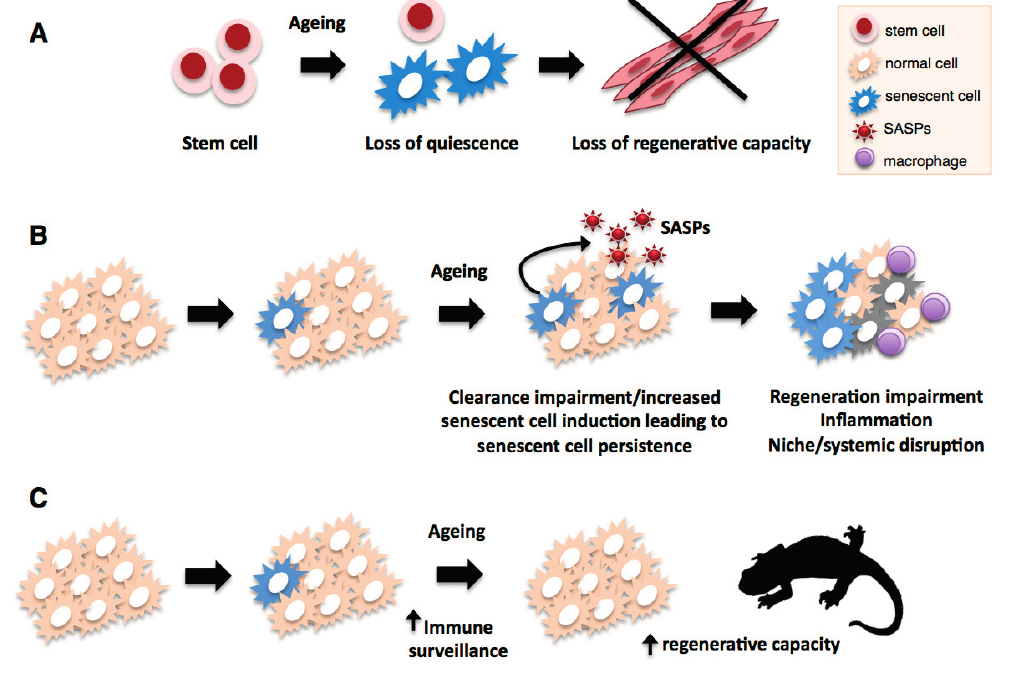
Figure 4. Impact of cellular senescence on regenerative processes during aging. Senescent cells accumulate in most organisms as they age, and this can negatively affect various regenerative processes. In the case of aged mammalian stem cells such as satellite cells ( A ), an age-associated switch to cellular senescence leads to loss of quiescence resulting in impaired regenerative ability; In addition to direct effects on regenerative capacity, senescent cells could promote tissue disruption, inflammation and niche or systemic alterations ( B ) through their phenotype (SASP), leading to further regenerative impairment; Senescent cell accumulation through aging can result from increases in stimuli that trigger cellular senescence (e.g., ROS, DNA damage, telomere attrition) or impairments in the immune-mediated clearance mechanism. In contrast to mammals, salamanders ( C ) have highly efficient mechanisms of senescence immunesurveillance which prevent senescent cell accumulation and could support their extensive regenerative abilities through